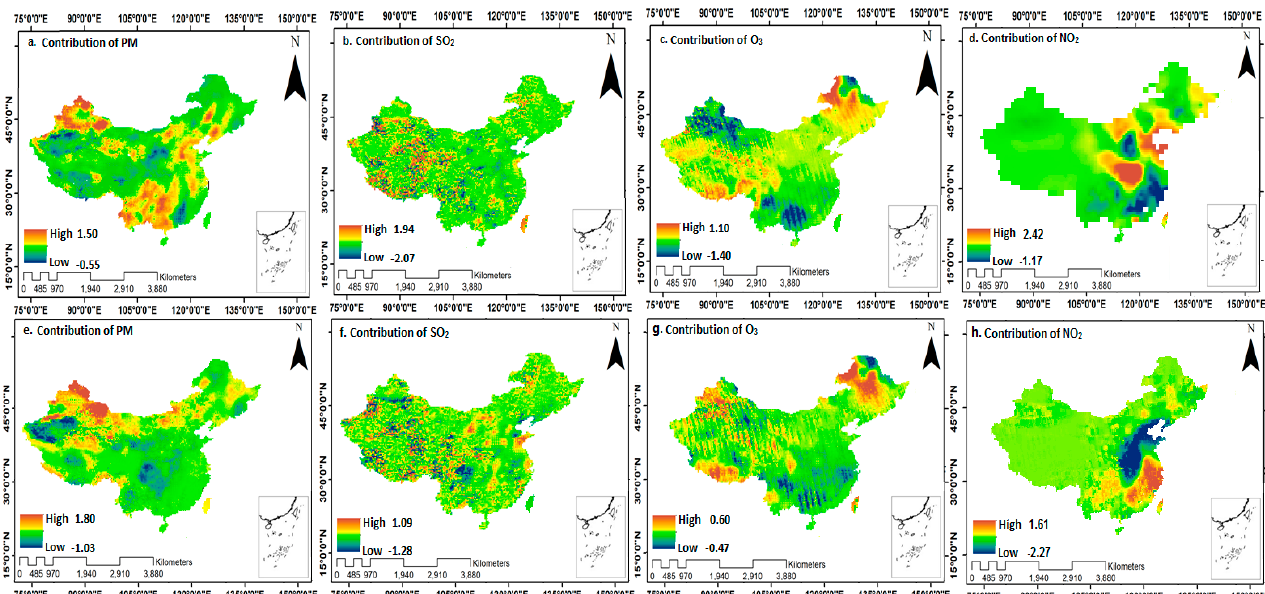
Figure 11. Contribution of air pollutants to temperature maximum (°C) pa tt ern changes. Note: Pre-scenario ( a , b , c , d ) and Post-scenario ( e , f , g , h ).